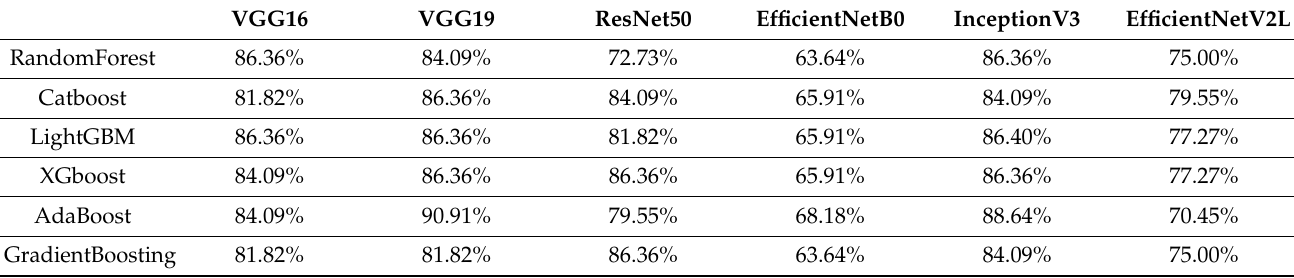
Table A2. Accuracy of each model combination for gray